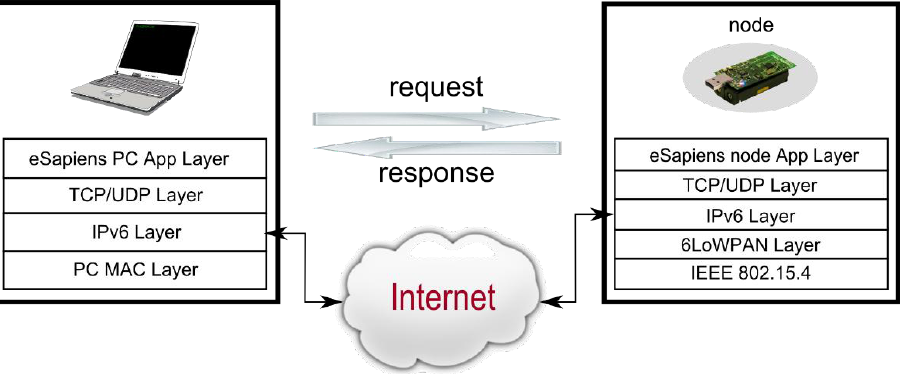
Figure 22. Example of data mining, using real-time environmental information on